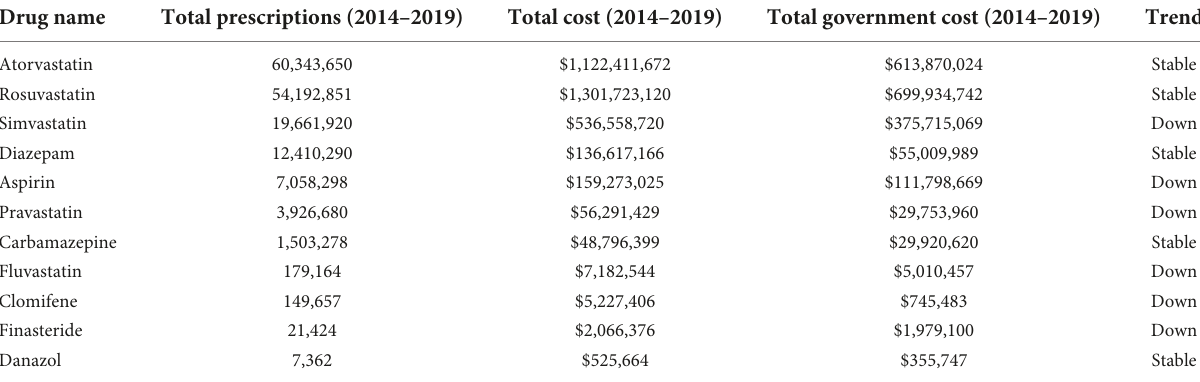
TABLE 4 PBS data (2014–2019) showing prescription numbers and costs for members of the uncertain category of drugs associated with cataract (gray background = statins). Drug